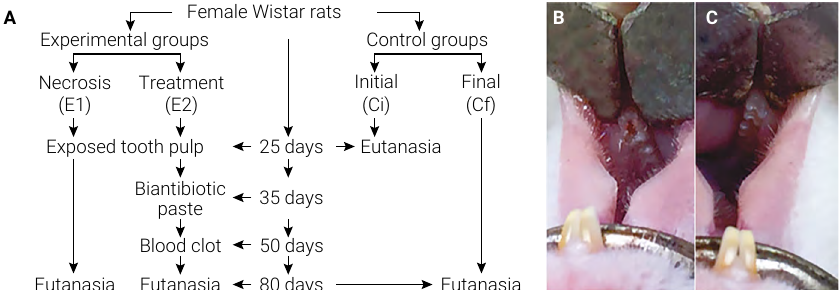
Figure 1. The experimental protocol and the procedures carried upon both experimental and control groups are shown in A. Photographs depict the isolation of the mandibular first molar with its pulp exposed (B) and the intact mandibular first molar that served as control